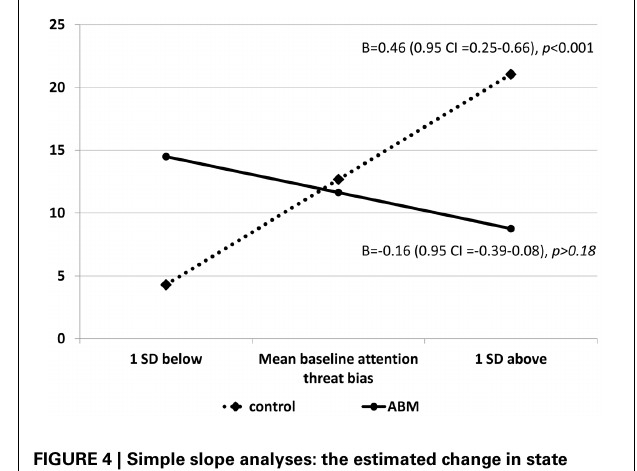
FIGURE 3 | State Anxiety Scores (STAI-S) and standard error bars for participants with baseline threat vigilance pre- and during the social stressor task by attention training condition. ∗∗ p < 0 . 0001; + p = 0 . 06.